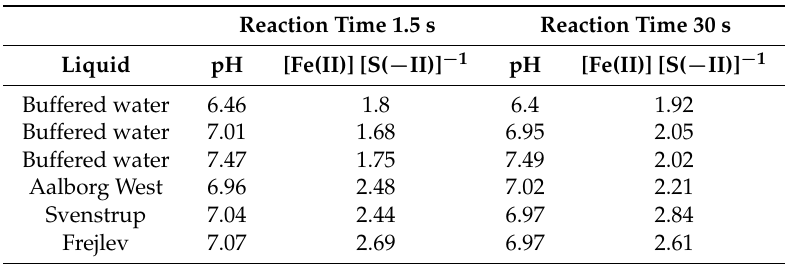
Table 2. Initial molar ratios of ferrous iron to sulfide after mixing in the 3-way valve (Figure 1).